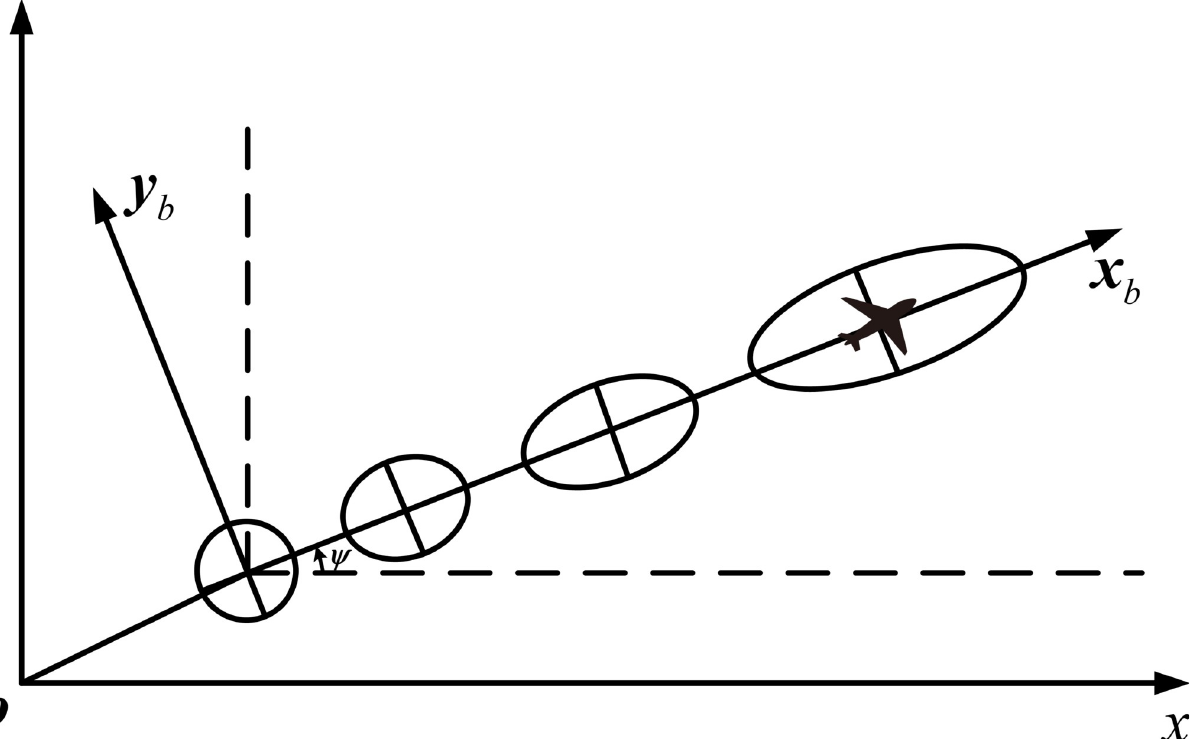
Fig 3. Trajectory error elliptical evolution in the carrier coordinate